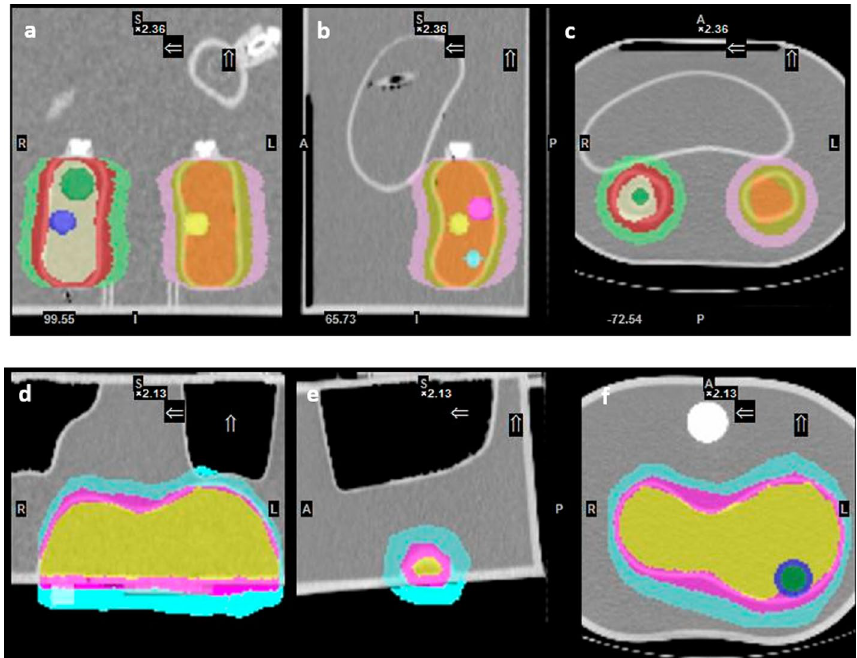
Fig. 7 Delineation methods for the large organs in the anthropomorphic phantoms. The top images ( a – c ) show the delineation of the kidneys in the liver/kidney phantom, and the bottom images ( d – f ) show the delineation of the liver cavity in the torso